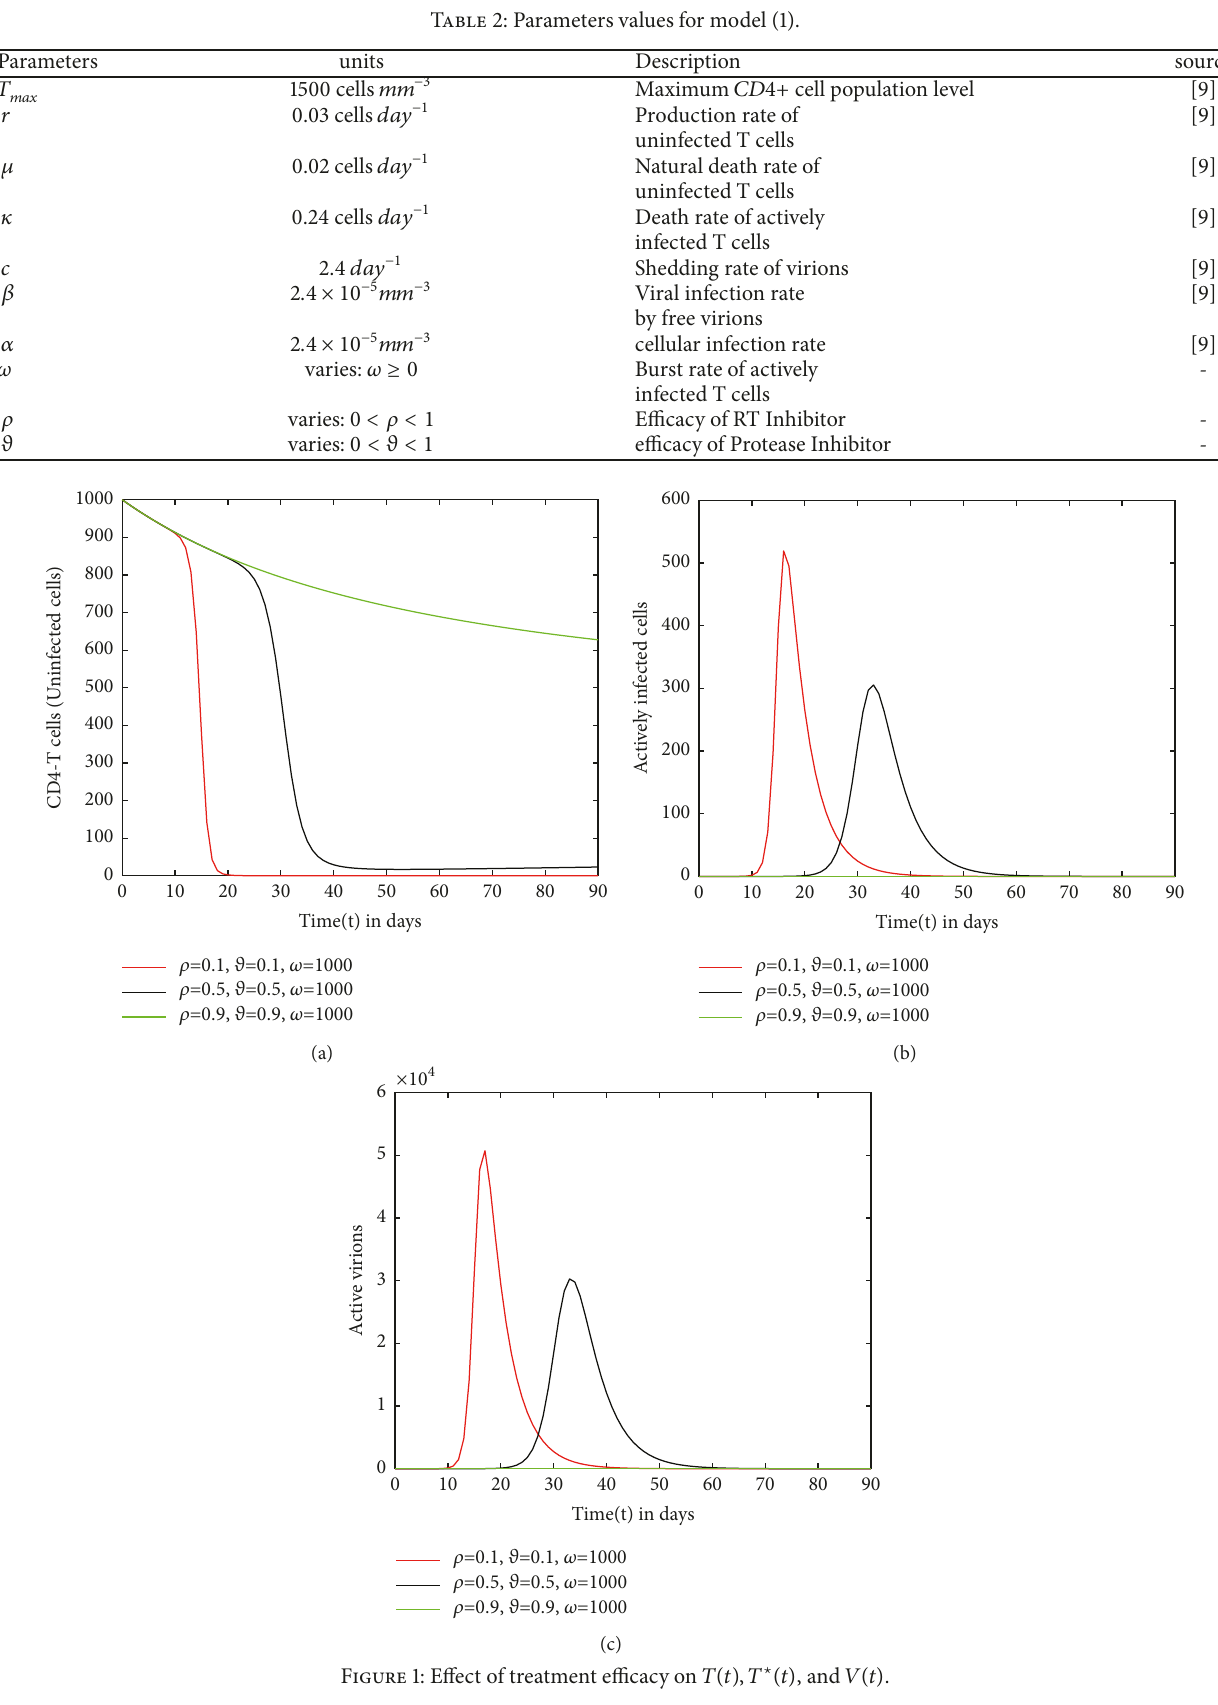
Table 2: Parameters values for model (1).